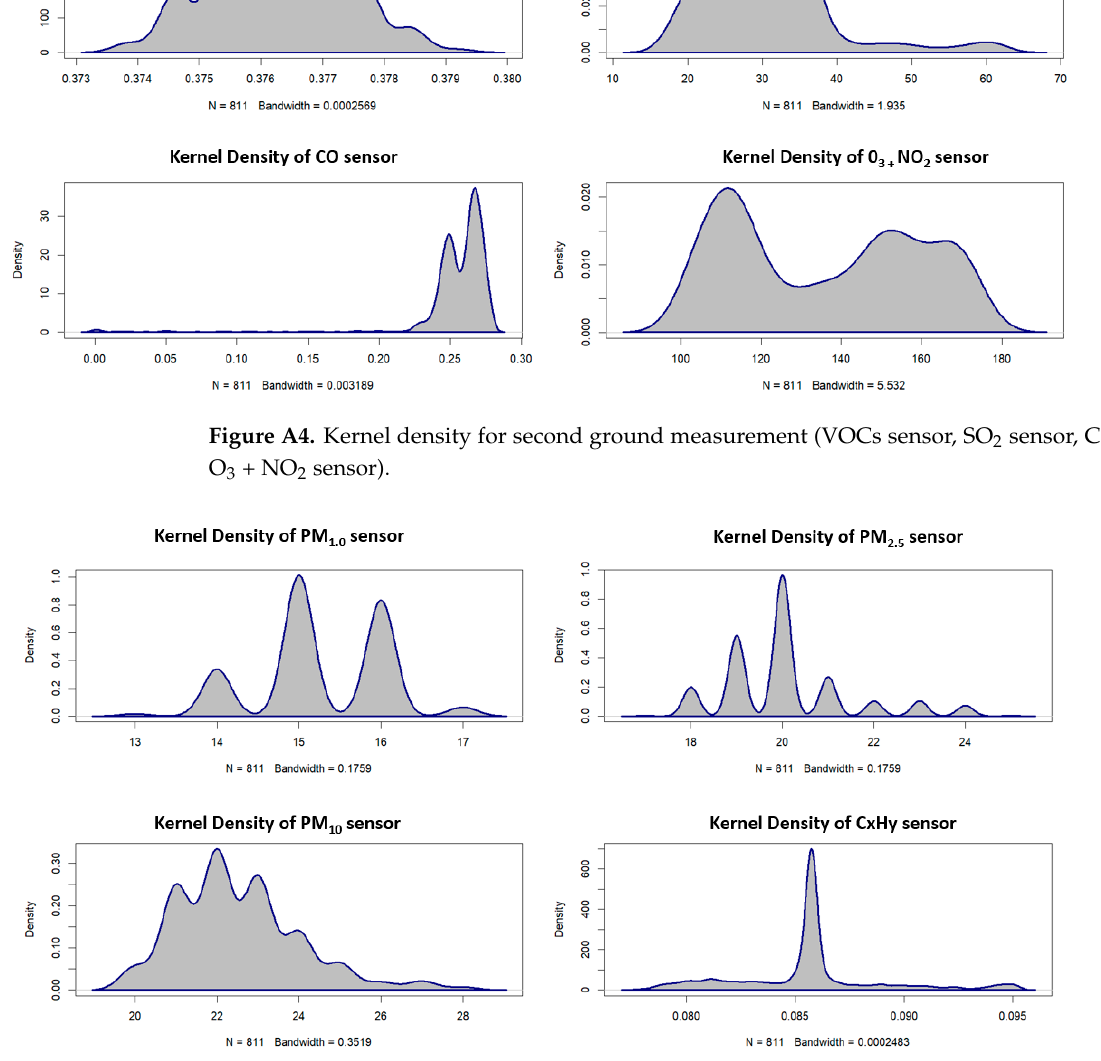
Figure A5. Kernel density for first second measurement (PM 1.0 sensor, PM 2.5 sensor, PM 10 sensor, C X H Y sensor).